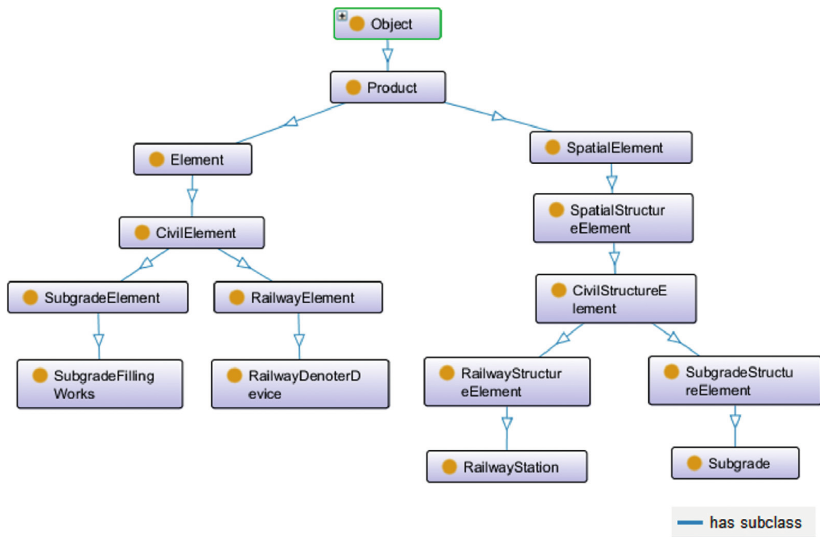
Figure 10: The extended entities in code